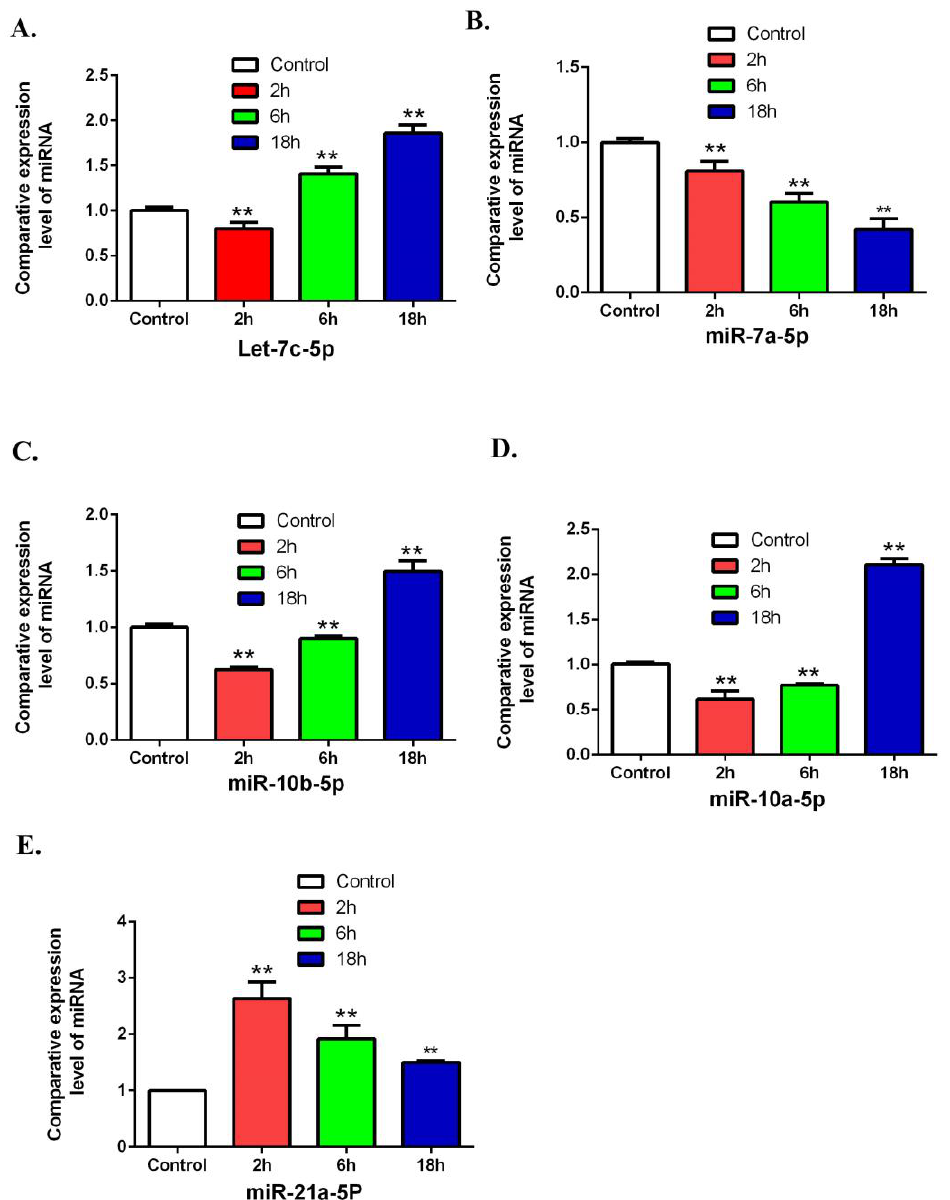
ff erentially expression of miRNAs by using QRT-PCR. The expressions Figure 8. Validating the differentially expression of miRNAs by using QRT-PCR. The expressions of Figure 8. Validating the di